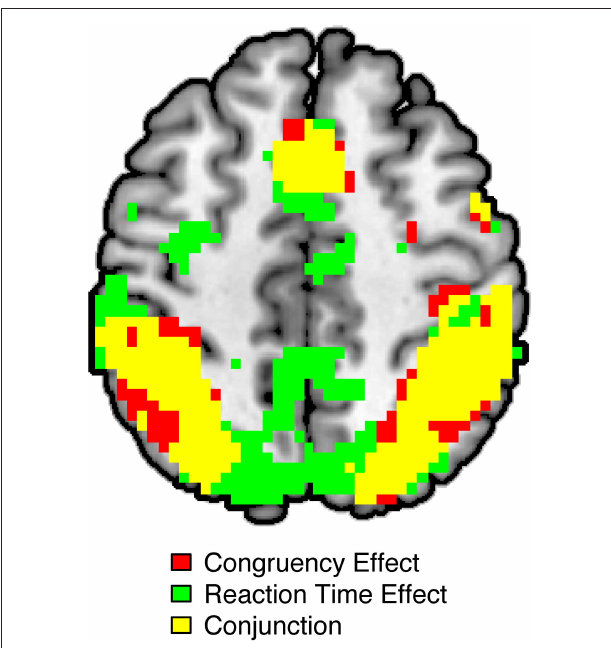
FIguRe 1 | Overlap between effects of congruency and effects of reaction time (RT) on BOLD amplitude as revealed by whole-brain analyses. Significant congruency effects (incongruent > congruent) are highlighted in red; significant RT effects (slow RT > fast RT) are indicated in green. The conjunction of these contrasts is highlighted in yellow. All activations are overlaid on the Ch2bet template in MNI space. Activations are displayed using a height threshold of p ≤ 0.005 and an extent threshold of k ≥ 30 voxels.